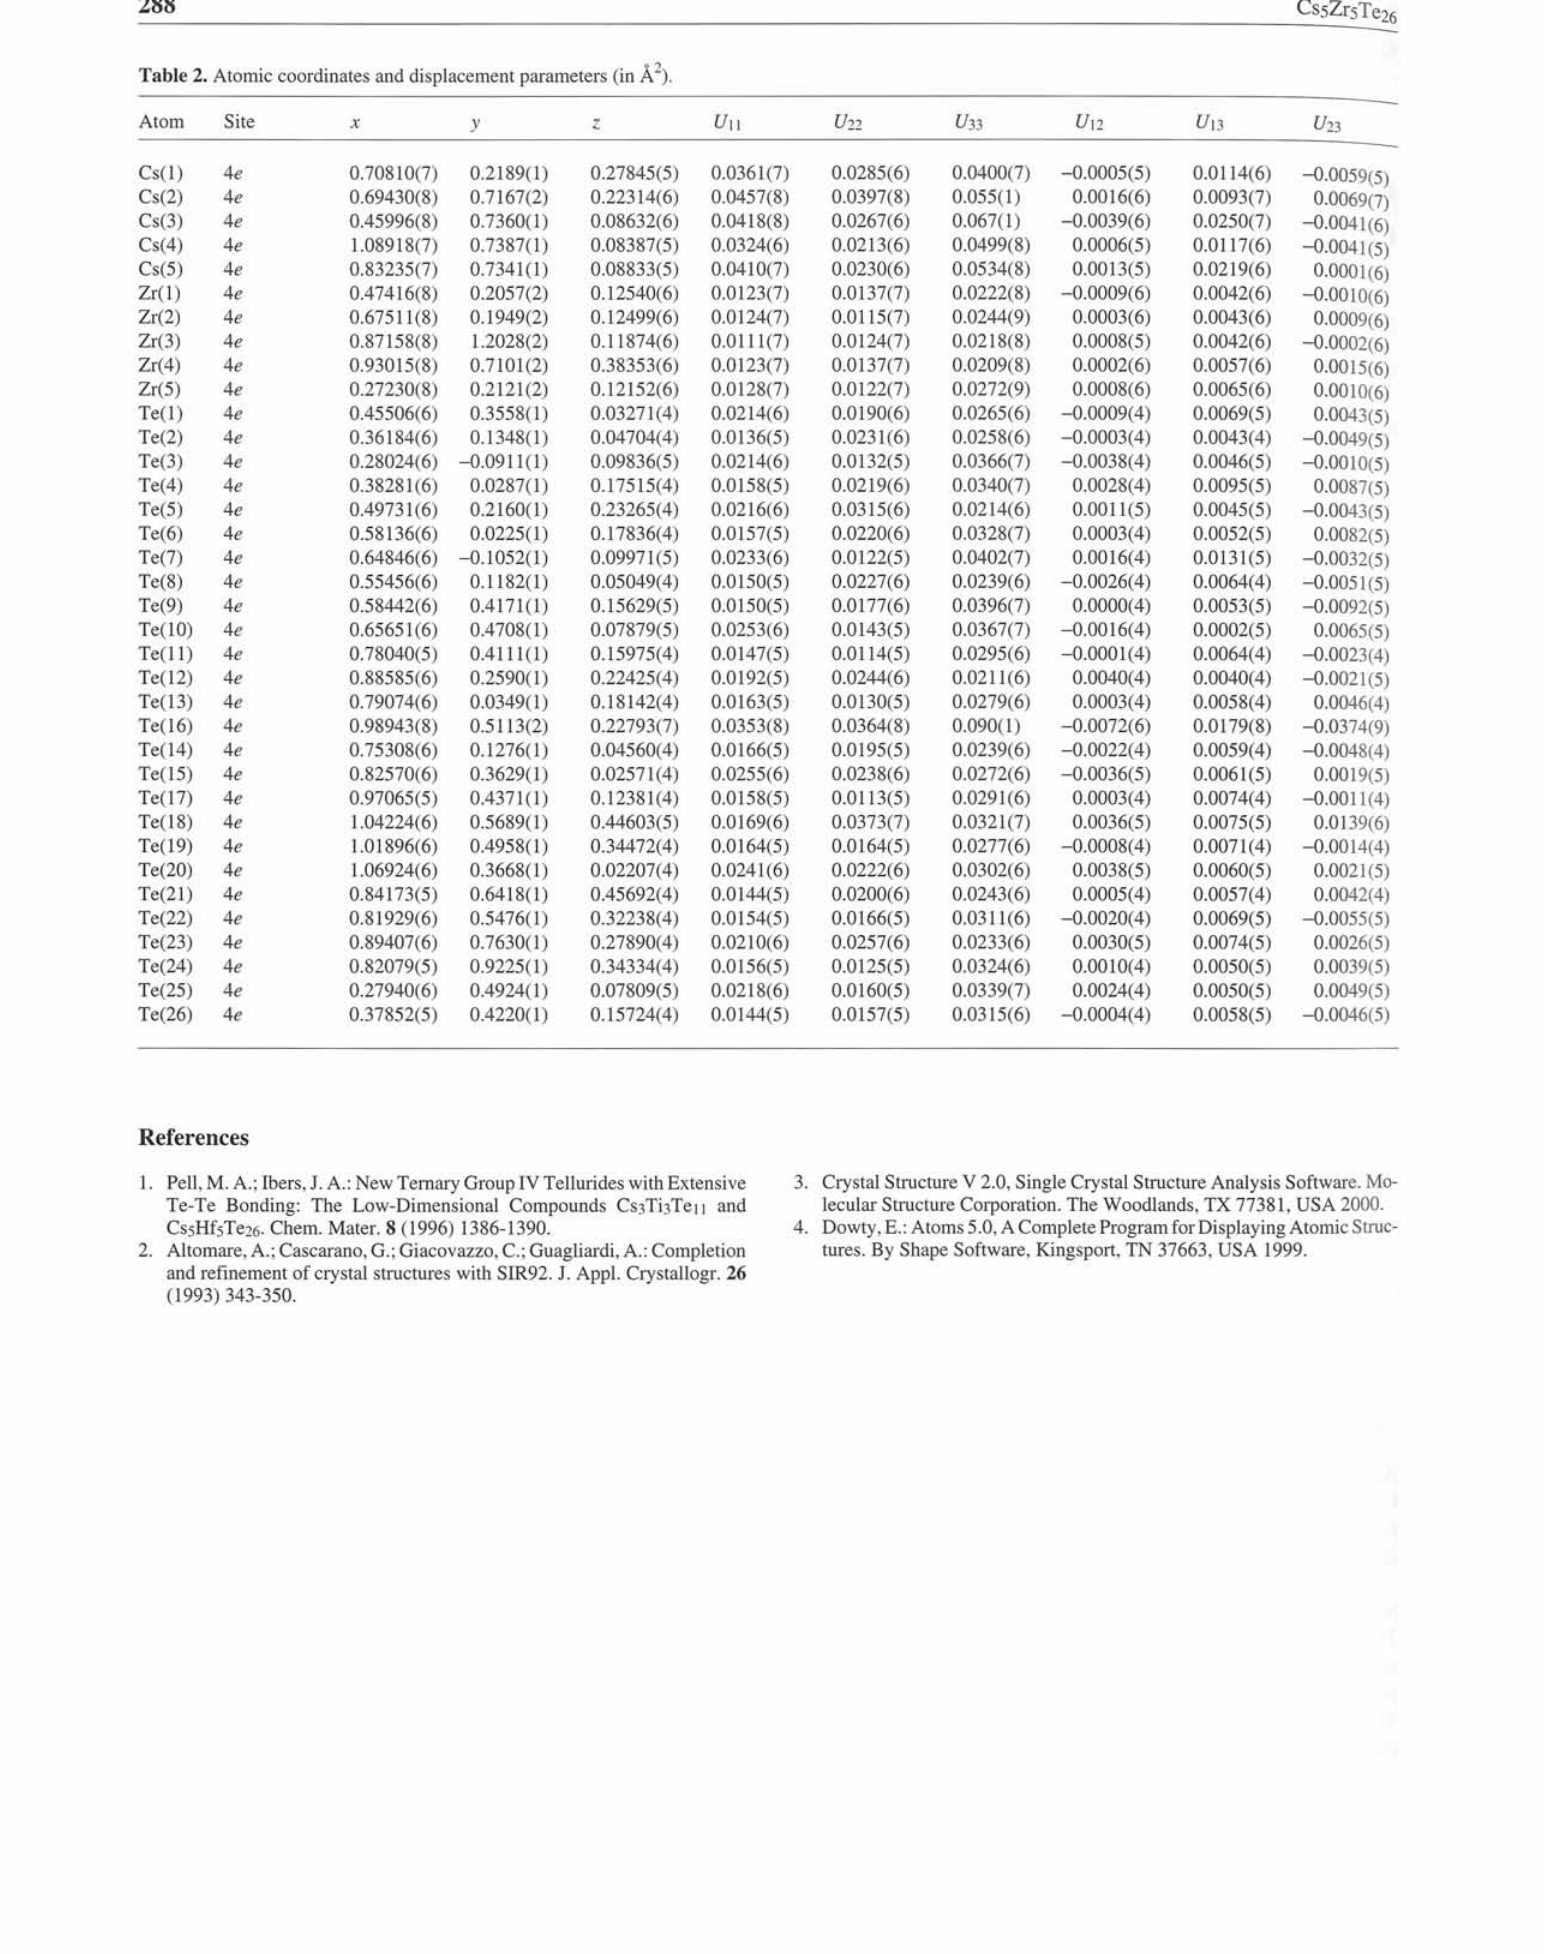
Table 2. Atomic coordinates and displacement parameters (in